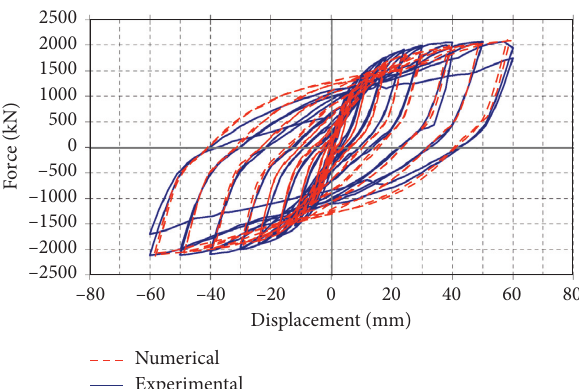
Figure 7: Comparison between experimental and computational hysteresis curves for the SPSW tested by Vian et al.